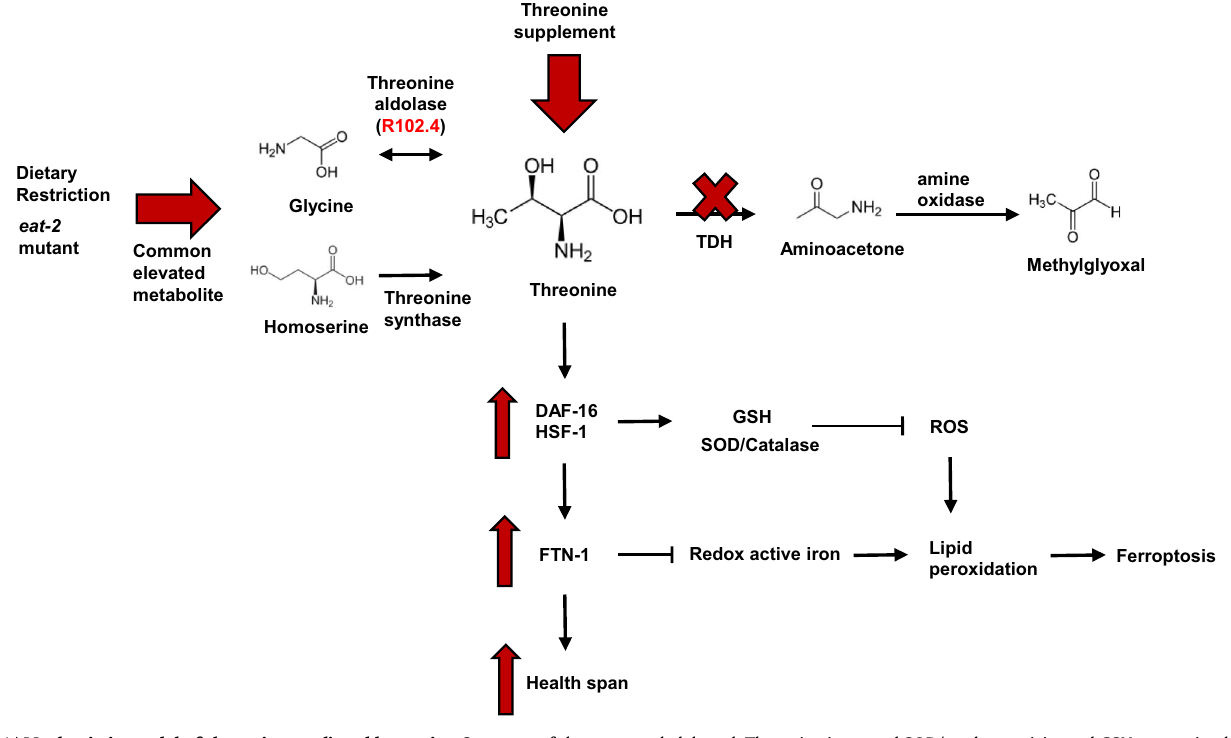
methylglyoxal. Threonine increased SOD/catalase activity and GSH expression by DAF-16/HSF-1 activation. Subsequently, and dependent on DAF-16 and HSF-1, activa- tion of ferritin protein, FTN-1, reduced redox active iron contents and eventually ferroptosis, which mediates lifespan extension and health